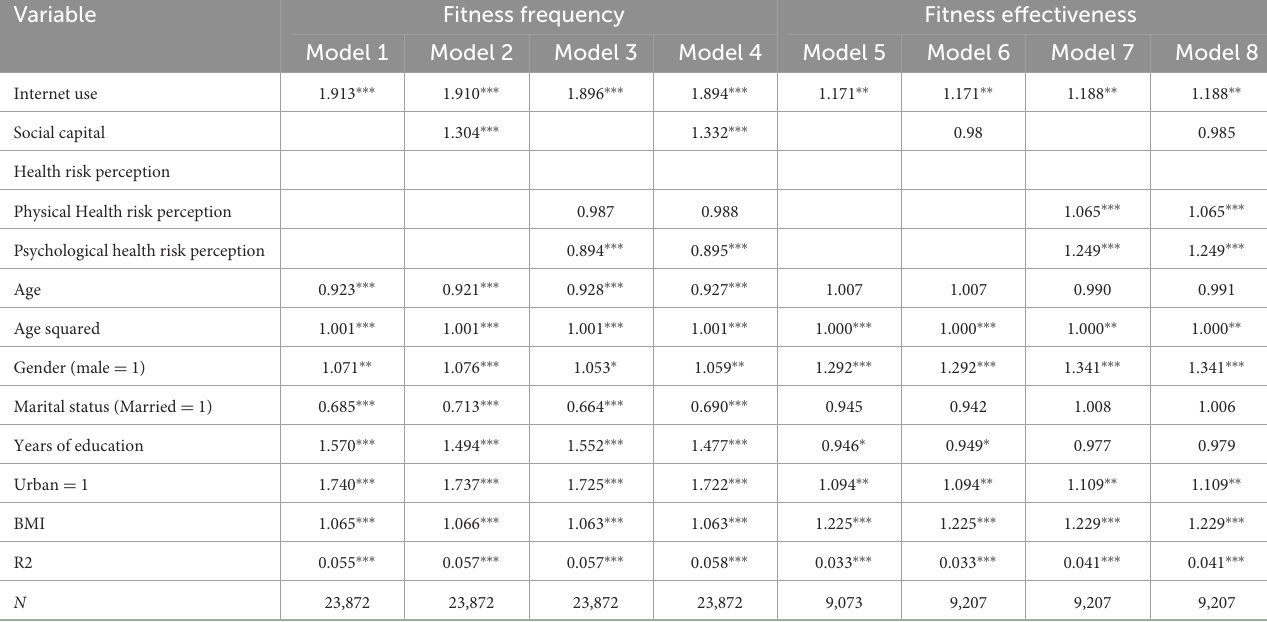
TABLE 3 The influence of the Internet on the frequency and fitness effect of residents’ physical fitness under regular epidemic prevention and control.